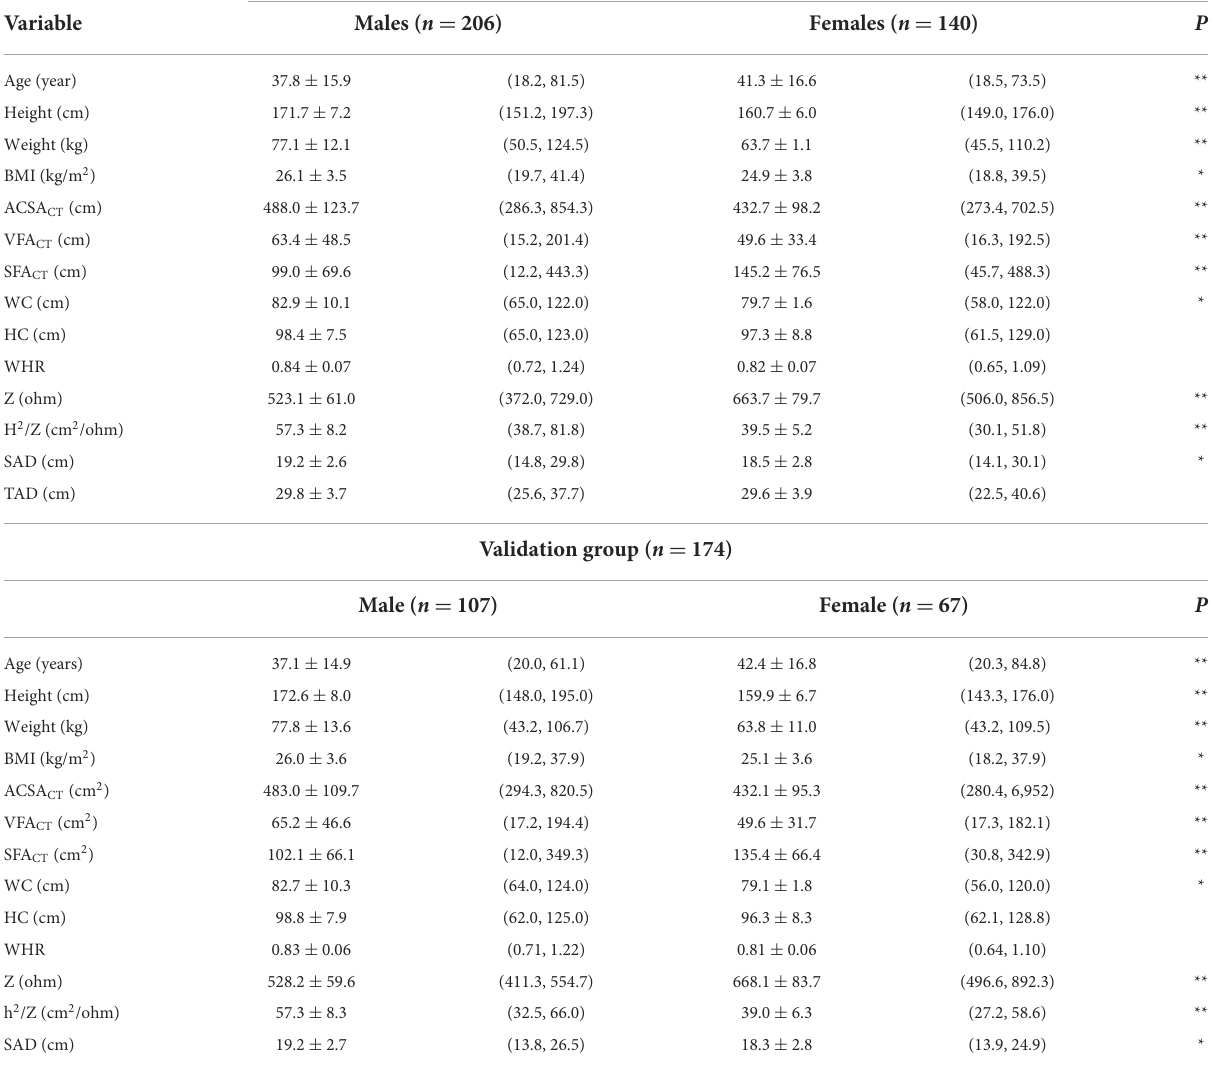
TABLE 1 Demographic and physical characteristics of the study